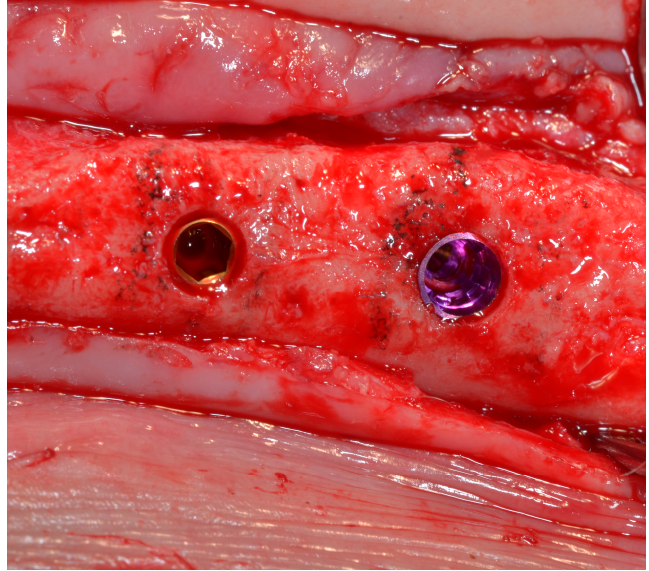
Figure 3. Each hemi-mandible received four tapered implants positioned at crestal bone level.